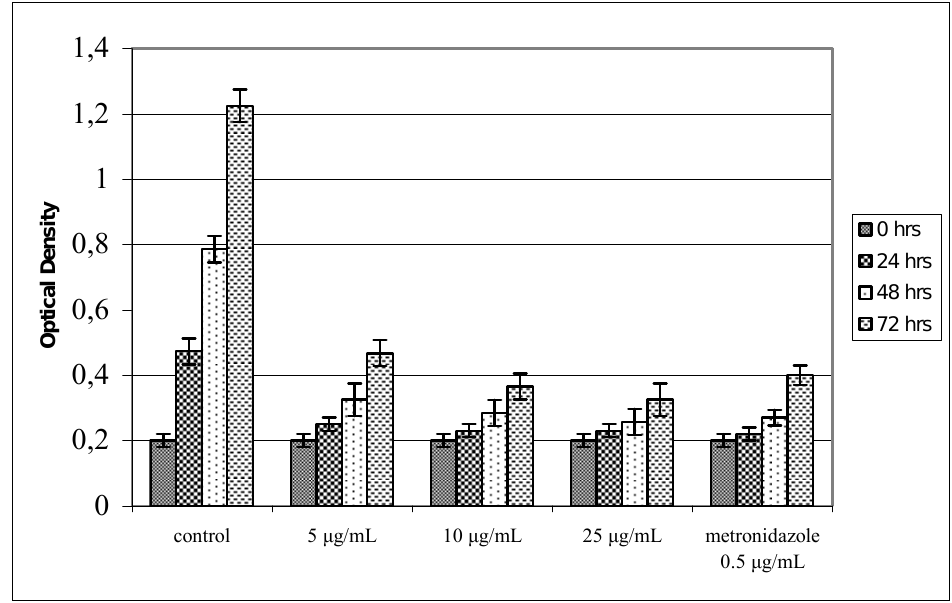
Figure 5 . Antibacterial activity of aegelinol ( 5 ) against H. pylori growth expressed as O.D. at 450 nm. Control cultures were made culturing the bacterium without and with